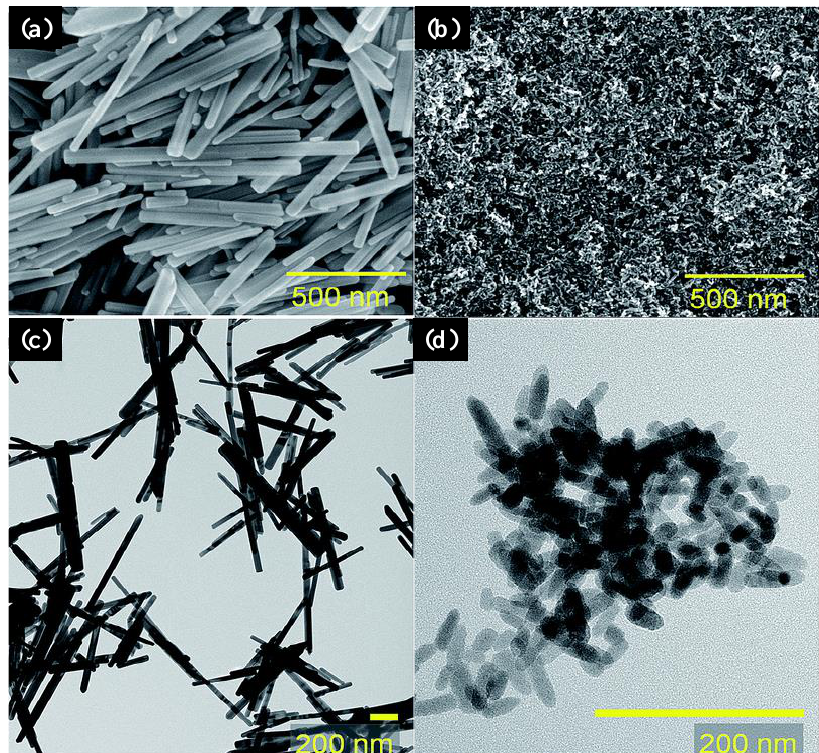
Figure 9. SEM images for ZnO ( a ) and Zn 0.85 Al 0.15 O ( b ) and TEM for ZnO ( c ) and Zn 0.85 Al 0.15 O ( d ). Figure adapted with permission from Reference [160]. Copyright 2020 RSC.